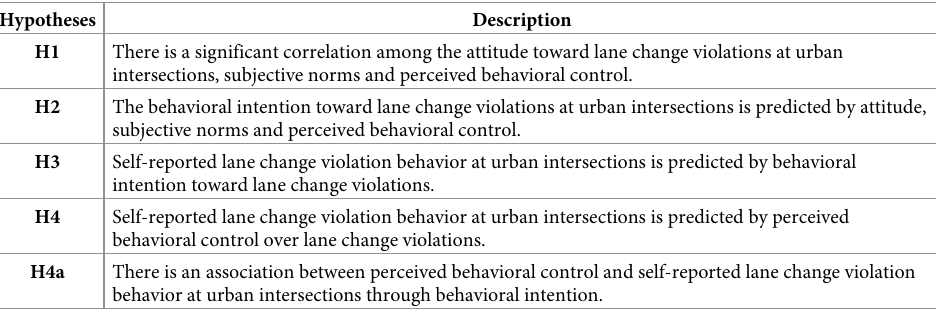
Table 1. Hypotheses of this